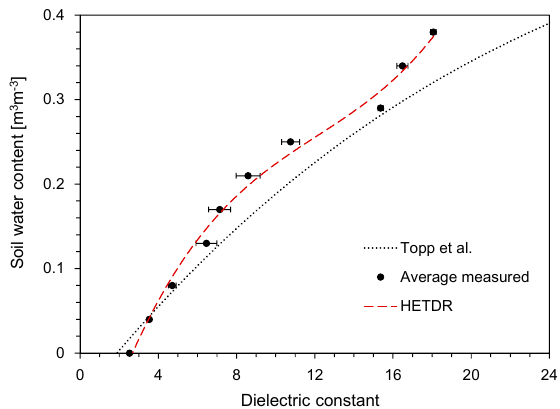
Figure 4. Relationships between the SWC and the dielectric constant for different probe spacings.